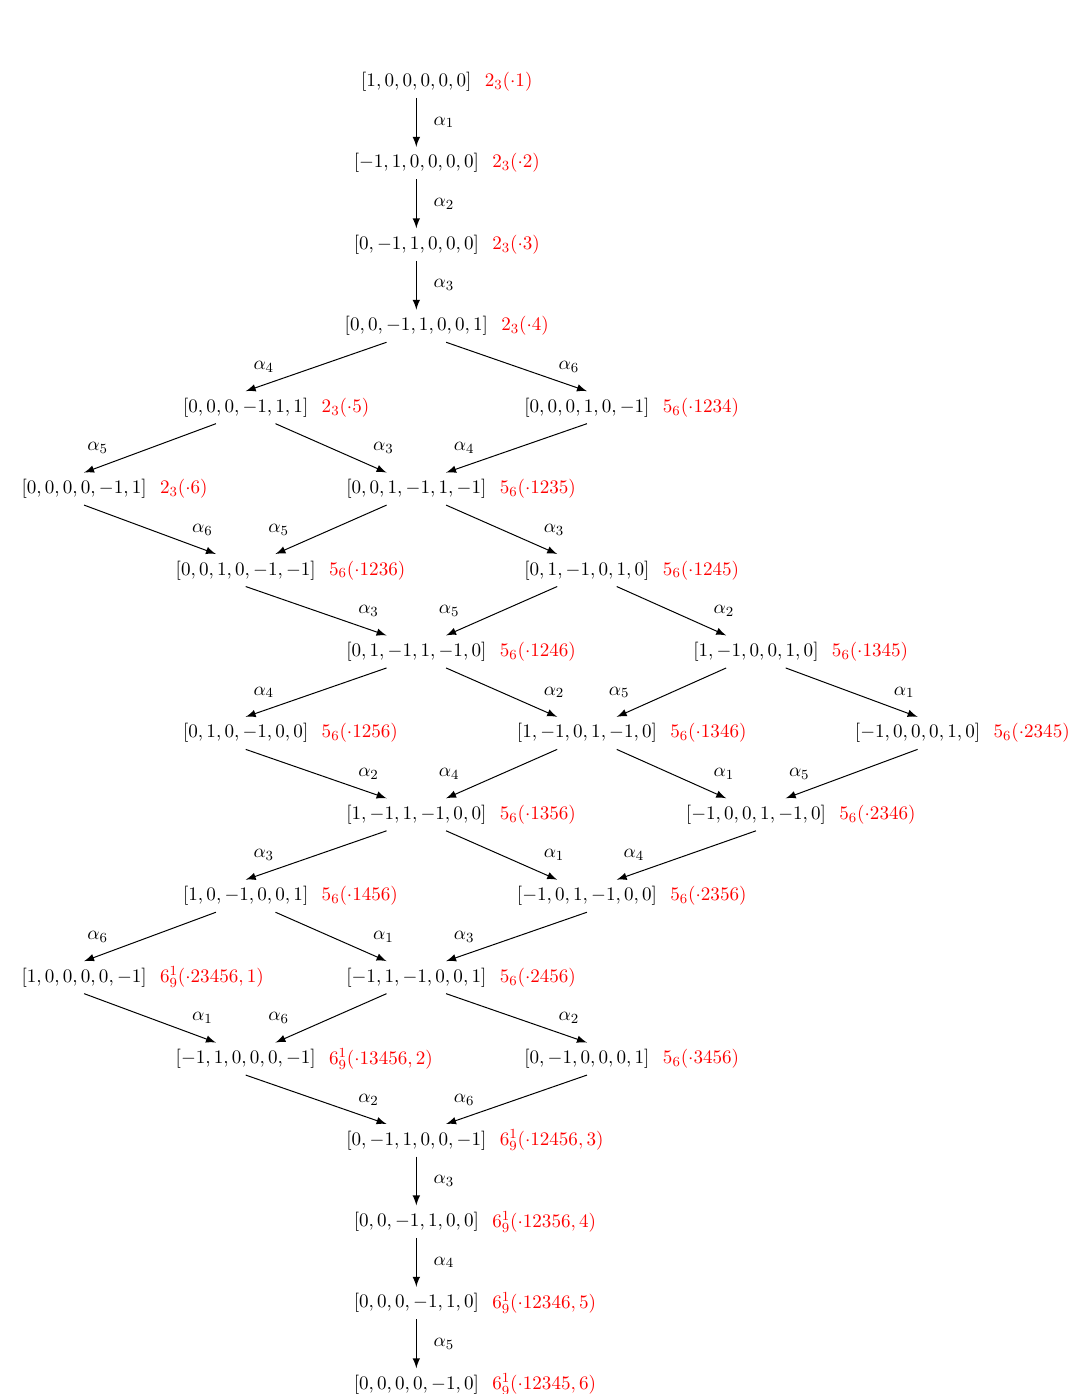
Table 2 . The weight diagram for the string multiplet in E